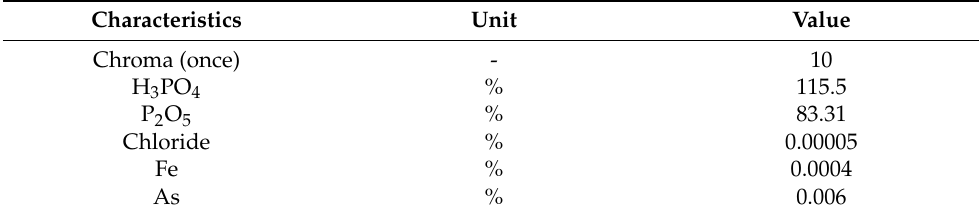
Table 1. Physicochemical properties of polyphosphoric acid.